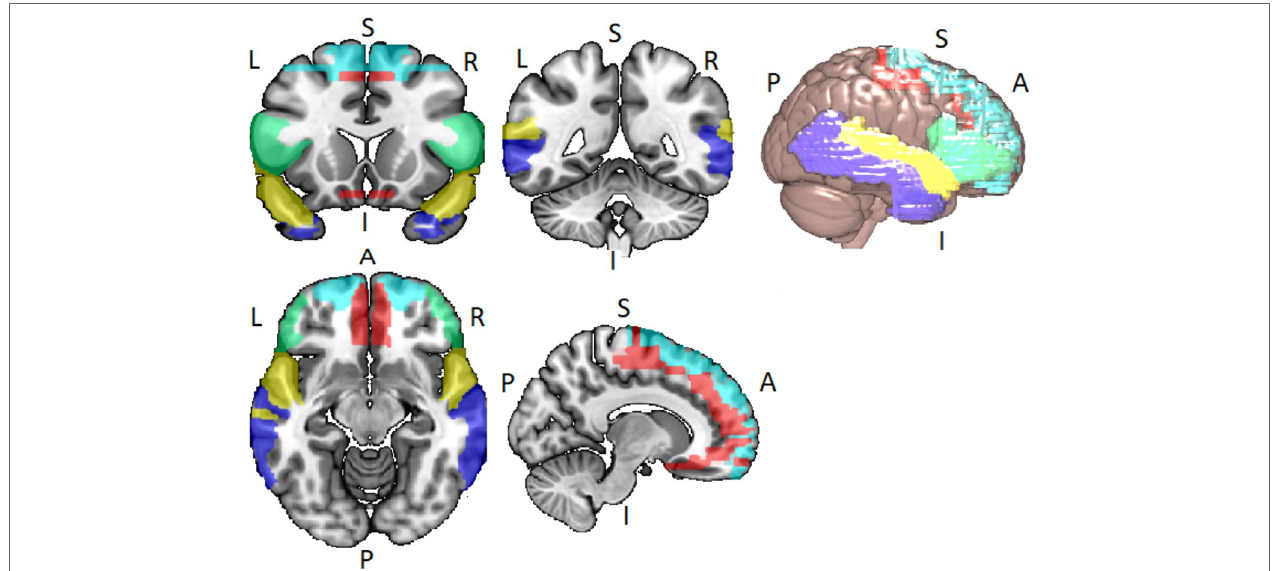
FIGURE 2 | Lateral temporal and frontal network encompassing the inferior frontal gyrus (IFG) (green), the superior frontal gyrus (SFG) (light blue), the Middle Frontal Gyrus (MFG) (red), the superior temporal gyrus (STG) (yellow), and the middle temporal gyrus (MTG) (blue). Networks identified via WFU_PickAtlas toolbox for SPM12 in Montreal Neurological Insitute (MNI)